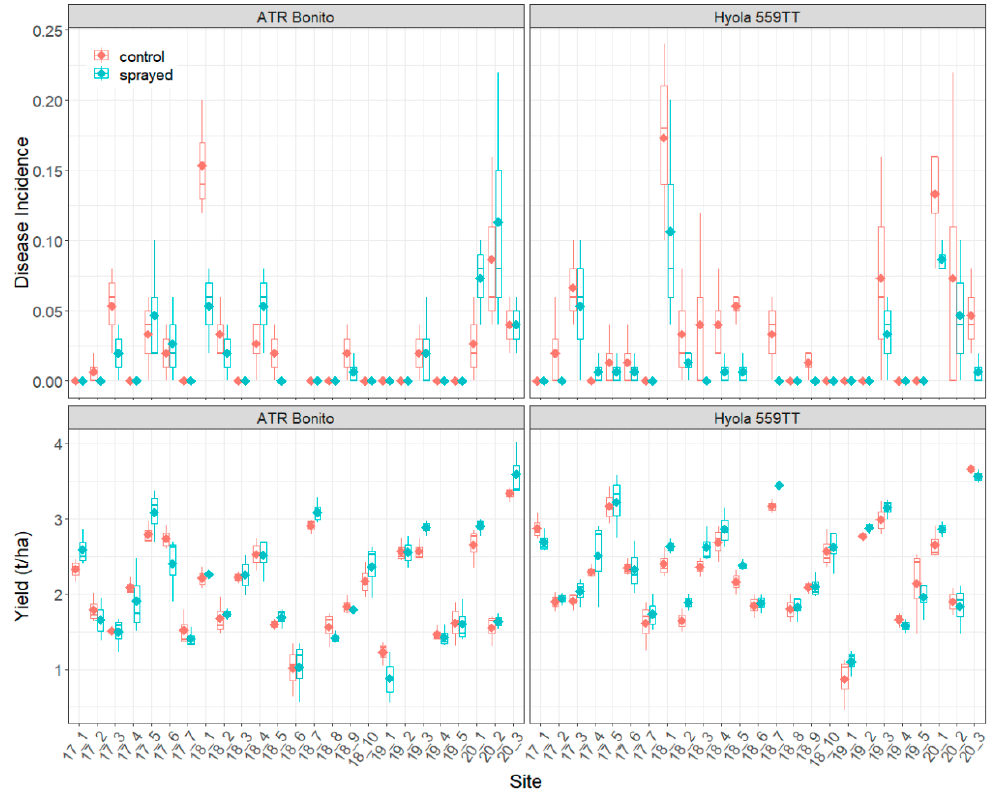
Figure 2. SSR disease incidence (proportion of infected plants) and final yield (t/ha) of ATR Bonito and Hyola 559TT canola plants sown at 25 sites across four growing seasons (2017–2020). Two management treatments were applied: no fungicide application (control) and fungicide application at 30% flowering (sprayed).